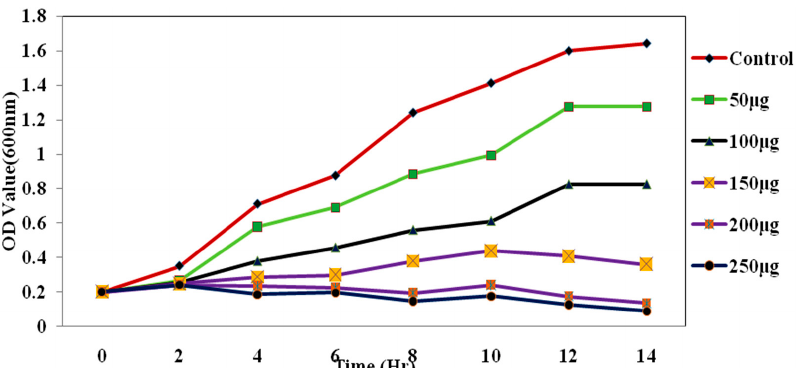
Fig. 4. The growth curve showing the various concentration of ciproflaxin conjugated chitosan nanoparticles and its effect on E.coli